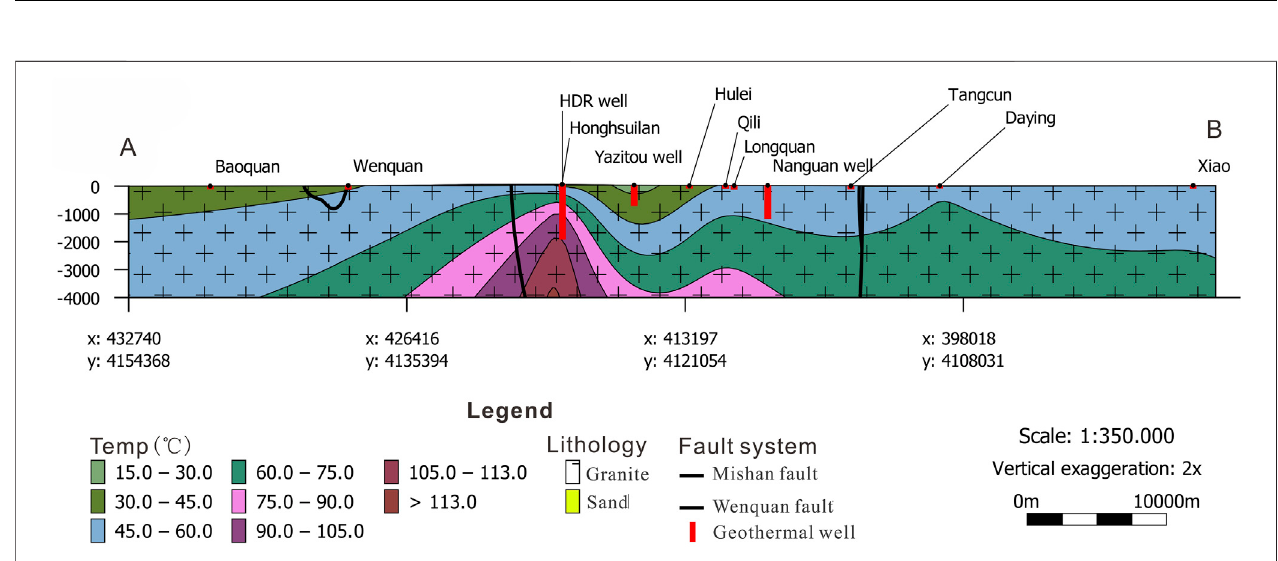
FIGURE 11 | 3D temperature model of the Weihai uplift, including the Mishan fault, the Wenquan fault, and the hot springs ( Figure 10 ).